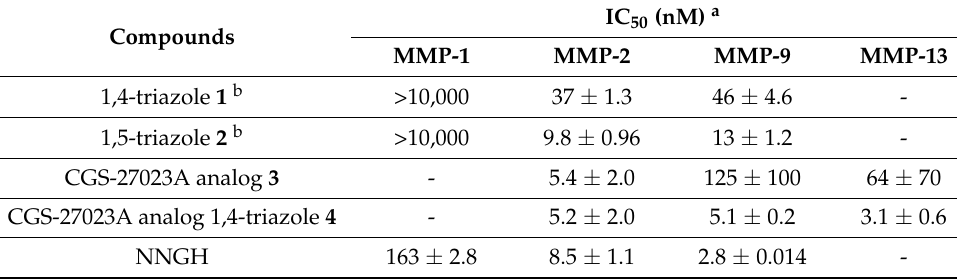
Table 1. MMP-2, MMP-9, and MMP-13 Inhibitory Potency and Selectivity.